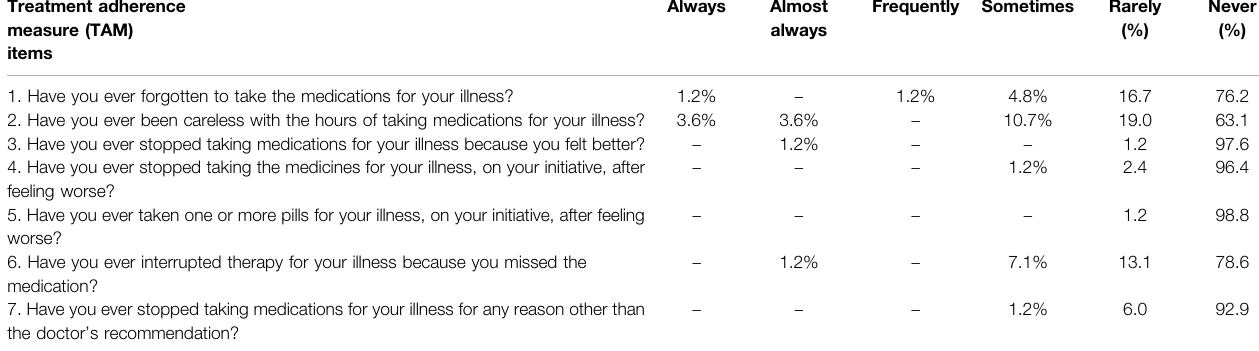
TABLE 3 | Distribution of the percentage of responses to the questions of the Treatment Adherence Measure (TAM) instrument elaborated by patients using immunomodulator ( n (cid:1) 84). Treatment adherence measure